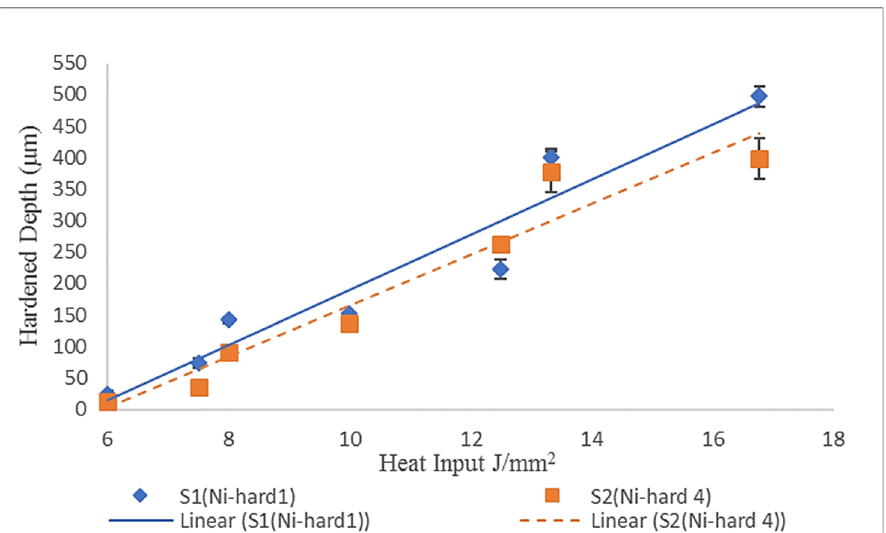
Figure 11. The hardened depth vs. the heat input values. Error bars represent standard deviation.